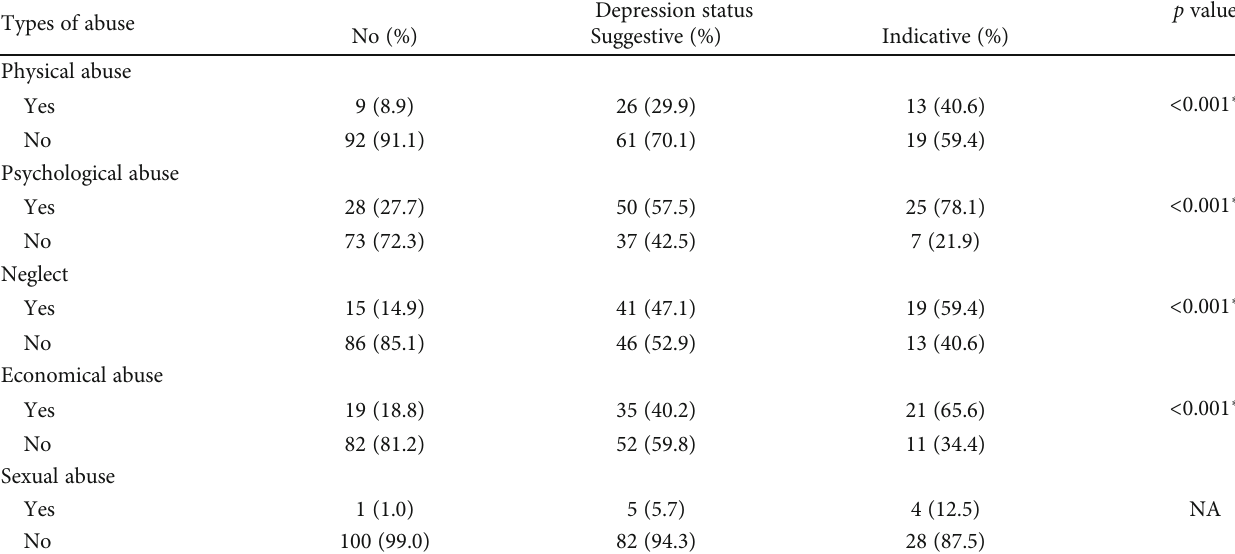
Table 3: Association between elderly abuse and